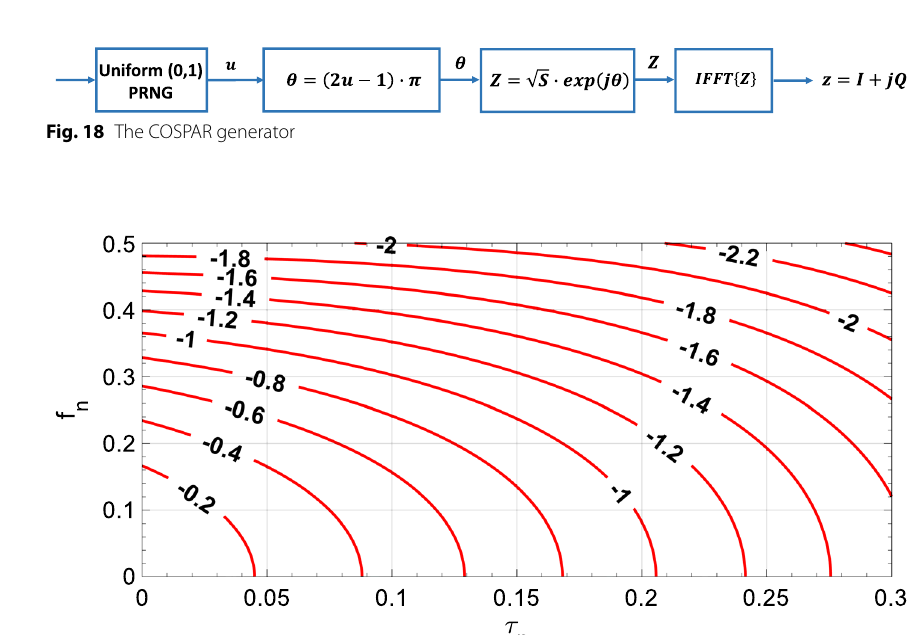
Fig. 19 Losses [dB] due to normalized delay τ n and Doppler frequency f